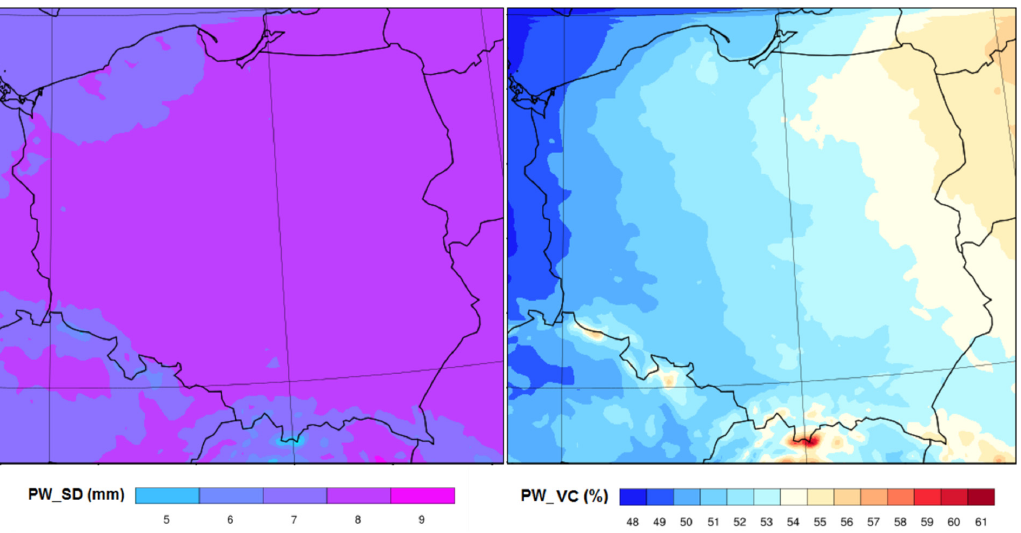
Figure 6. Standard deviation ( left ) and variability coefficient ( right ) of PW annual value over Poland for the years 1983–2010.